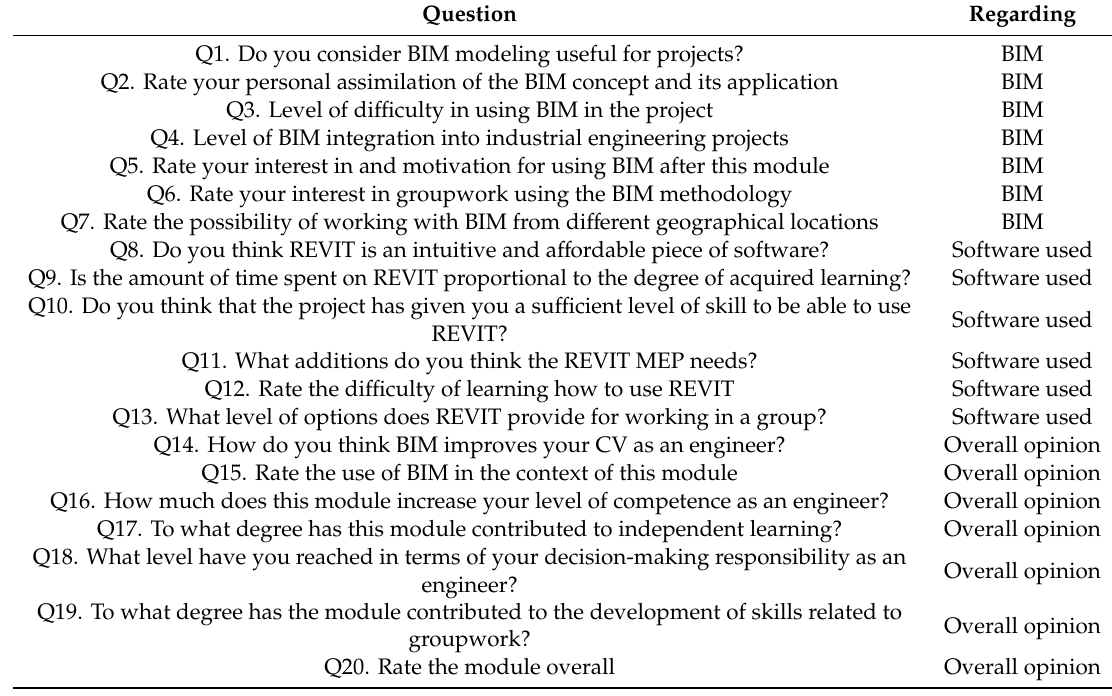
Table 2. Phase 2: Descriptive statistics of the students’ views regarding BIM. Question Min. Max